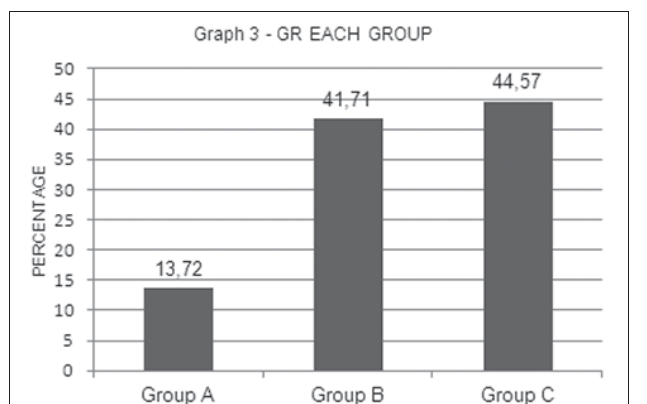
Fig. 3: gingival recession in age group